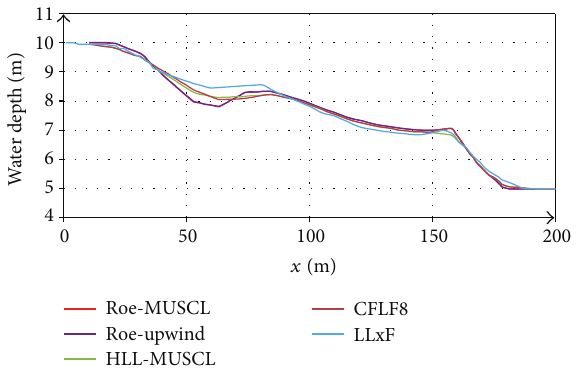
Figure 10: The comparison among various Riemann solvers used in Wang and Liu’s code (Reo-MUSCL, Reo-Upwind, HLL-MUSCL and CLFL8) and V-Break (LLxF).